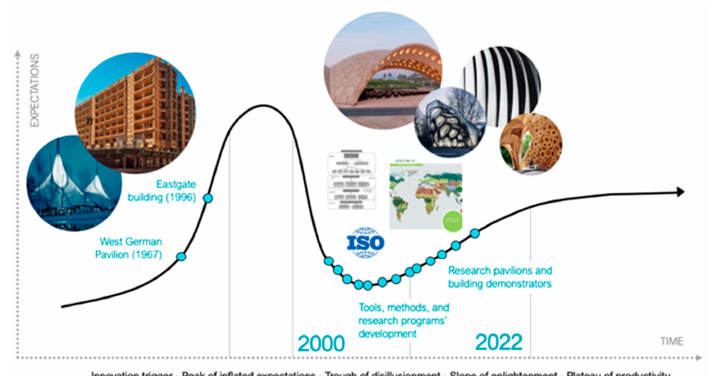
Figure 1. The development of biomimicry in architecture and urbanism understood through the hype cycle model. Content and information adapted from various sources: [8,15,18,22–26]. Credit: CC-BY-SA Estelle Cruz.